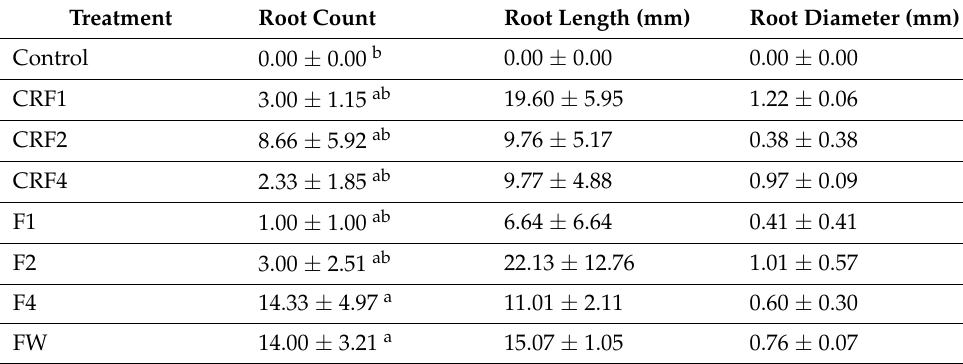
Table 3. Root growth parameters measured in March 2021 at a depth of 0–15.7 cm. A one-way analysis of variance (ANOVA) with a Tukey honestly significant difference (HSD) test was used to determine significant differences between means. Letters indicate statistically significant differences ( p ≤ 0.05). Data represents means ± standard error.